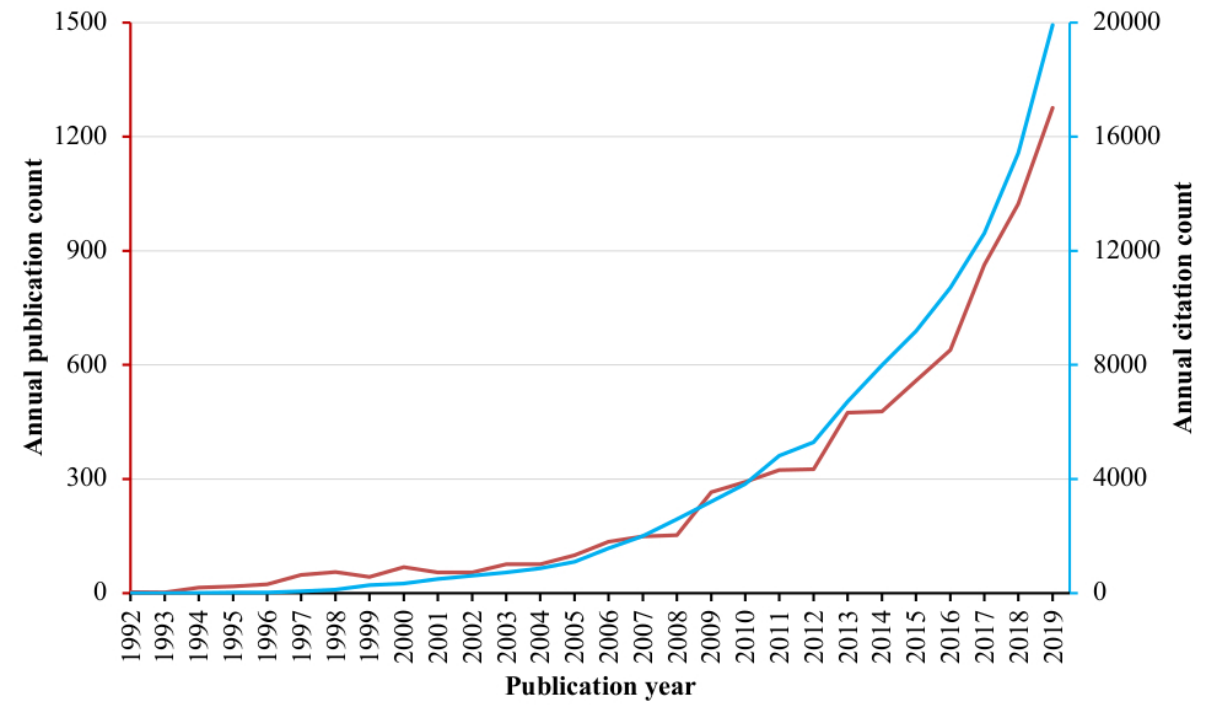
Figure 1. Annual publication and citation count of virtual reality research in medicine.